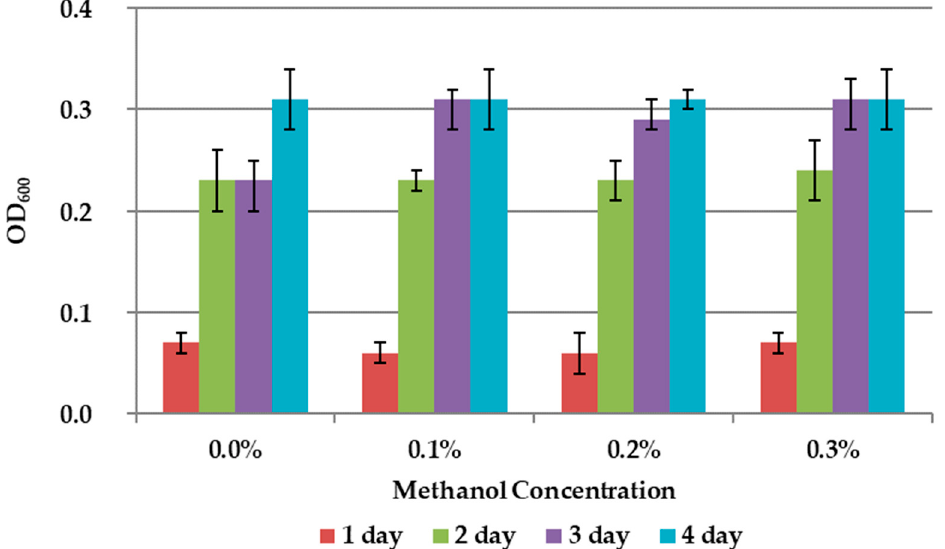
Minerals 2022 , 12 , x FOR PEER REVIEW 11 of 17 Figure 3. Growth dynamic of A. ferrooxidans TFBk in 9K medium with different concentrations of methanol. The y-axis shows the optical density (OD 600 ) of the medium with bacteria.